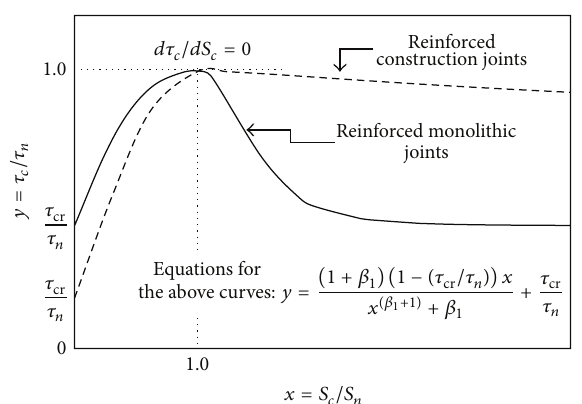
Figure 1: Generalization of shear stress-relative slip curve at concrete